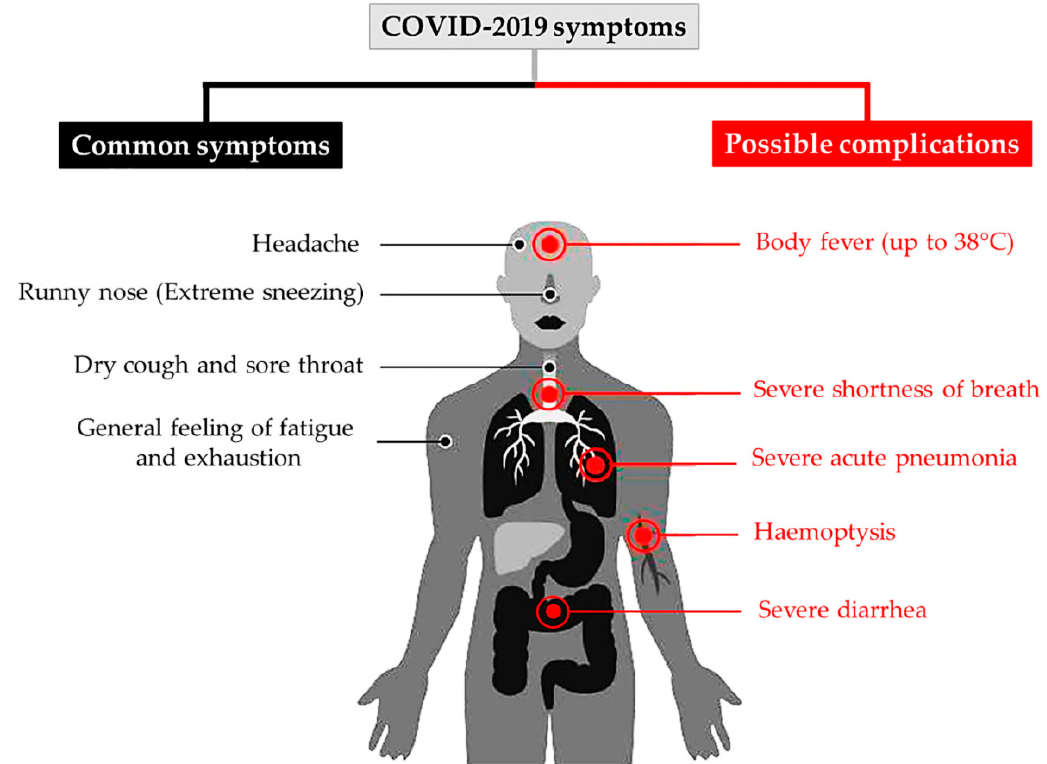
Figure 2. Some common symptoms observed in patients with COVID-19. Reproduced with permission from Ref. [8].